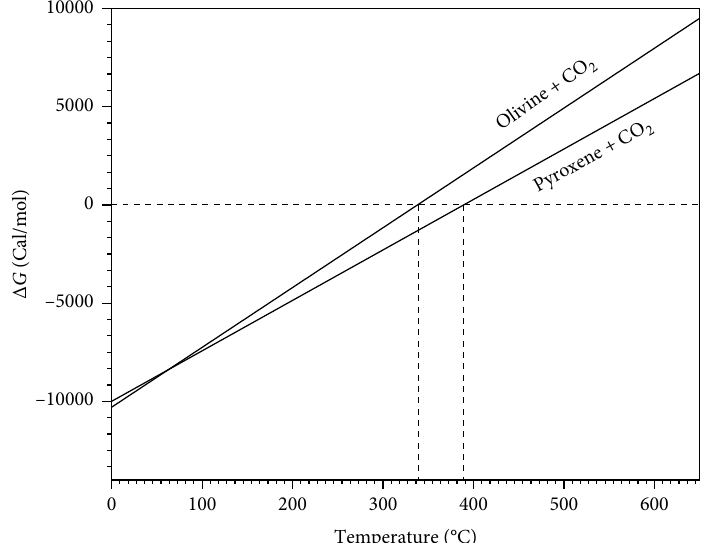
= 100 bar; modi fi ed after co2